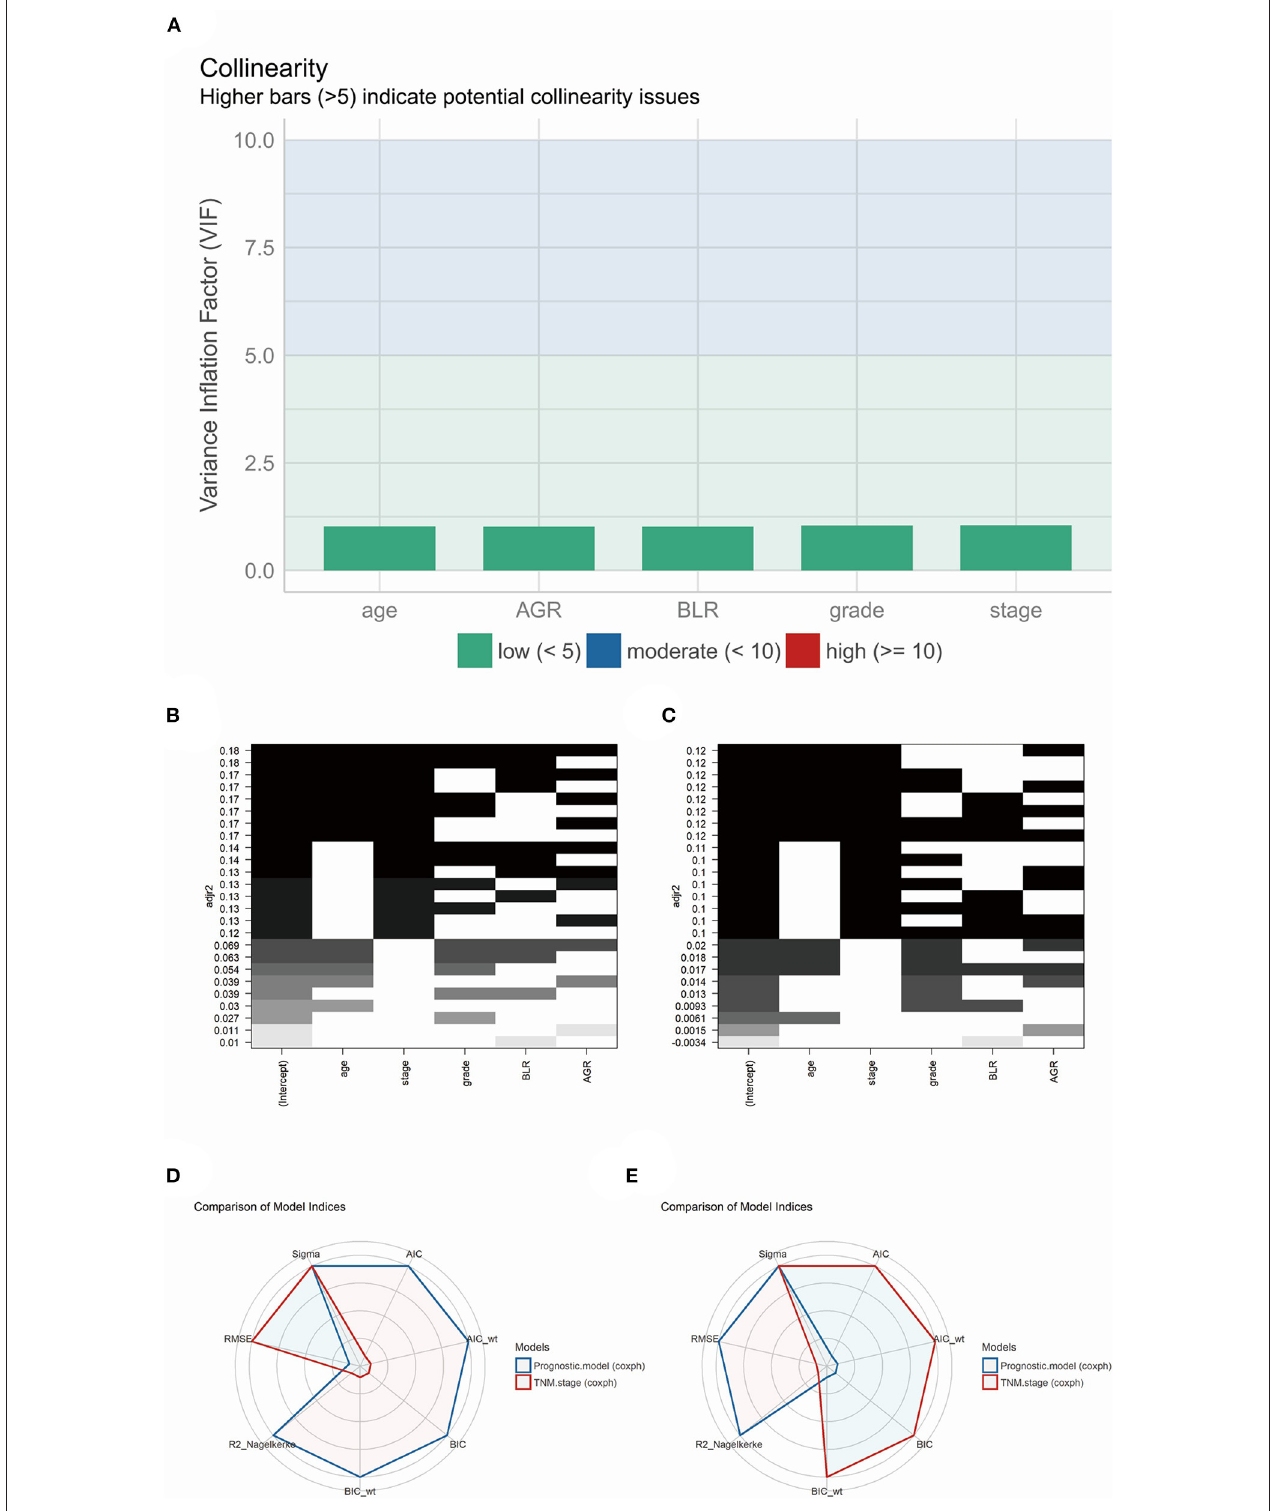
FIGURE 6 | (A) The model performance of collinearity. High bars ( > 5) indicate potential collinearity issues. (B) (training group) and (C) (validation group), the model performance of all-subsets regression analysis. (D) (training group) and (E) (validation group), radar plot indicating the comparison of different model indices between TNM staging system and prognostic